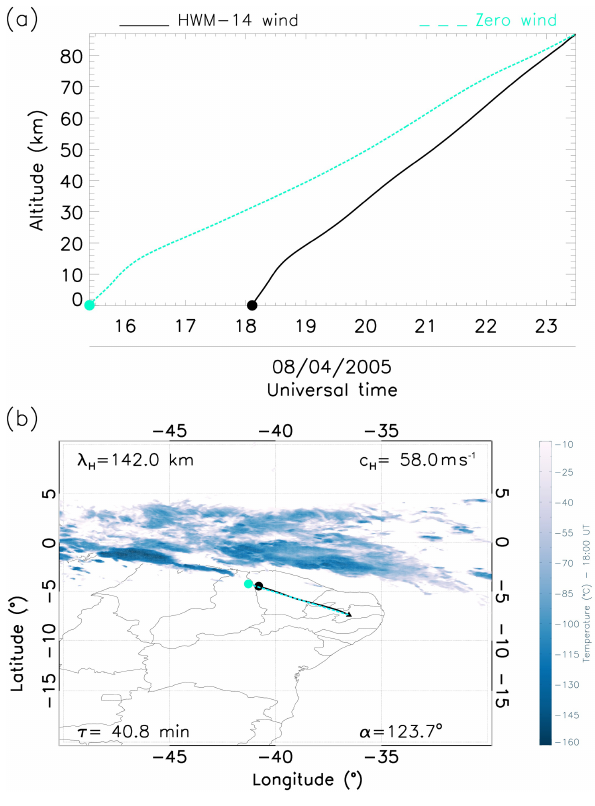
Figure 8. Same as Fig. 5 but for GW 5 .